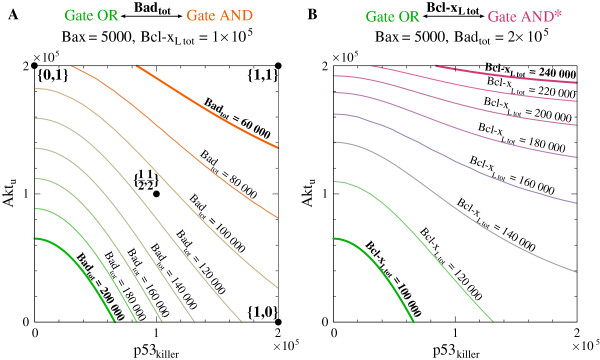
Transitions between gate types. (A) transition from gate OR to gate AND, (B) transition from gate OR to AND*. Apoptotic (Bax = Baxbif = 5000) isolines are plotted in the input signals (p53killer, Aktu)-plane. Black dots in (A) denote {p53killer, Aktu} pairs of input signals analyzed in Figures 9 and 10.